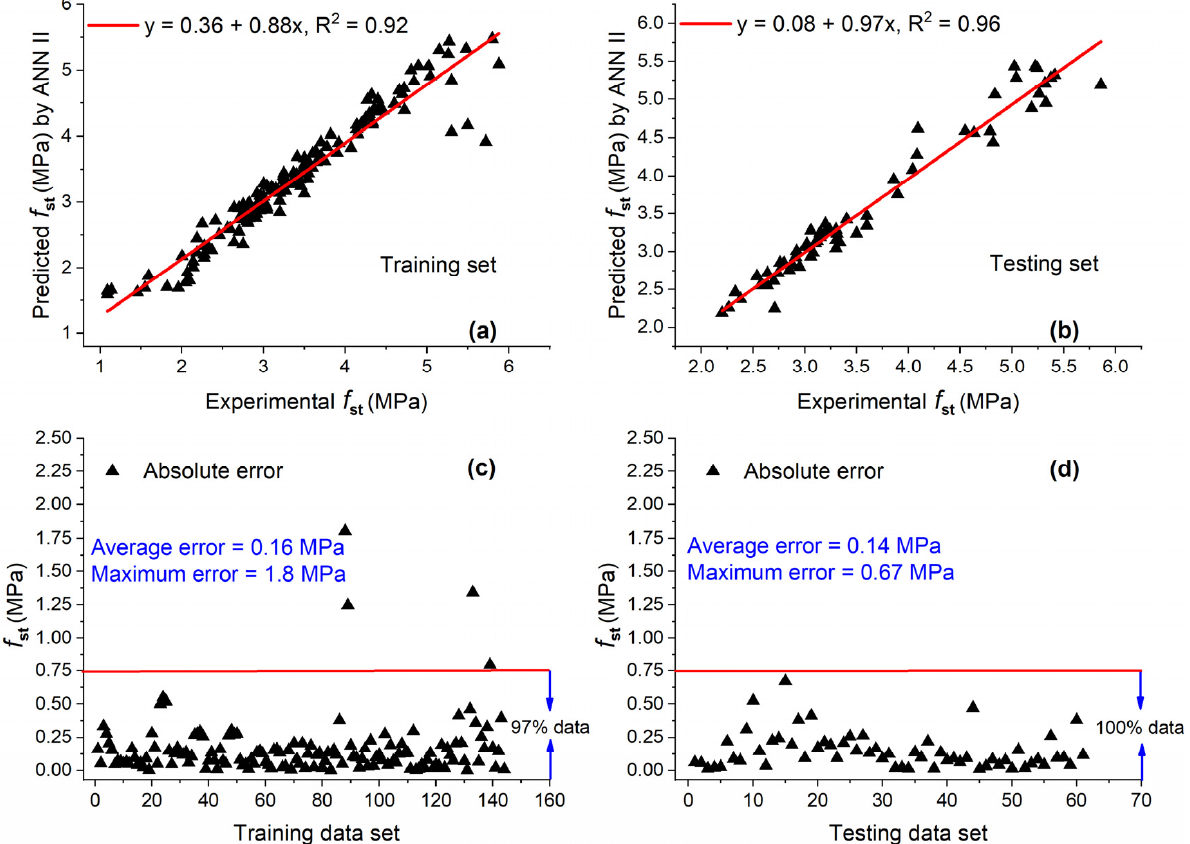
Figure 13. Experimental and predicted values of f st by ANN II for ( a ) training set and ( b ) testing set, and their corresponding absolute error for ( c ) training data set and ( d ) testing data set.